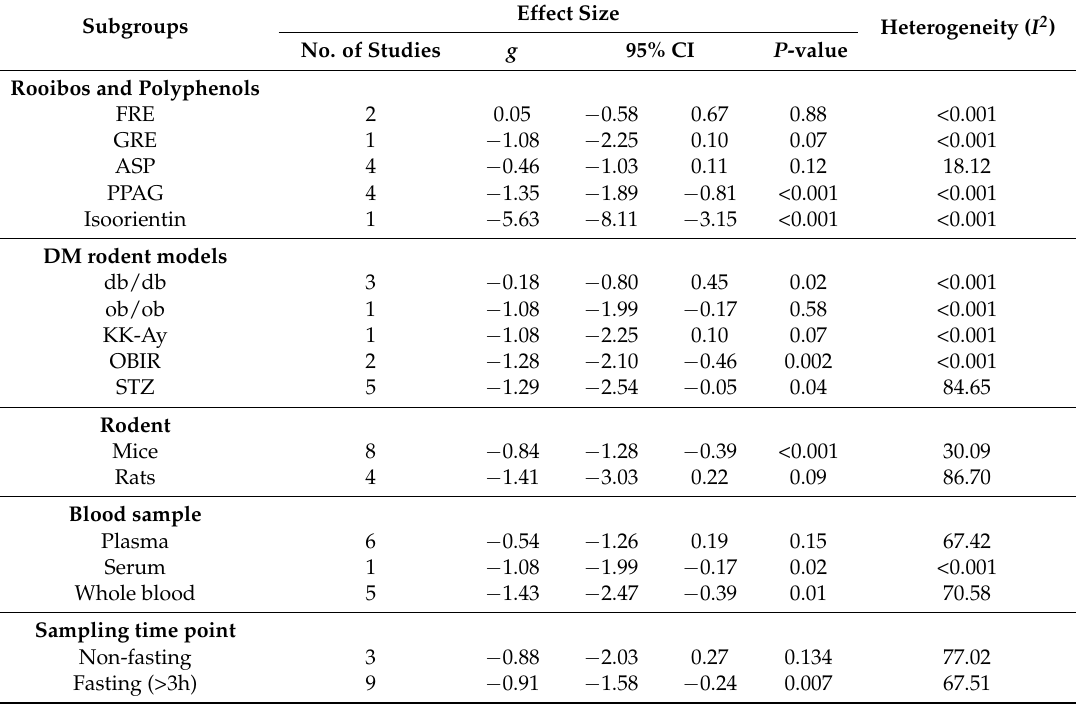
Table 2. Subgroup analyses.